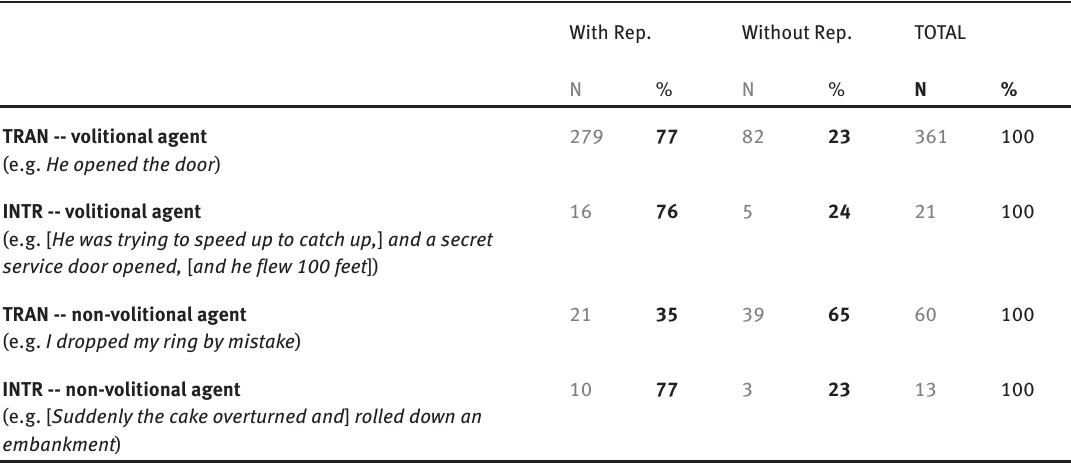
Table 4. Frequencies of representational gestures accompanying the causative-inchoative alternation with volitional or non- volitional agent